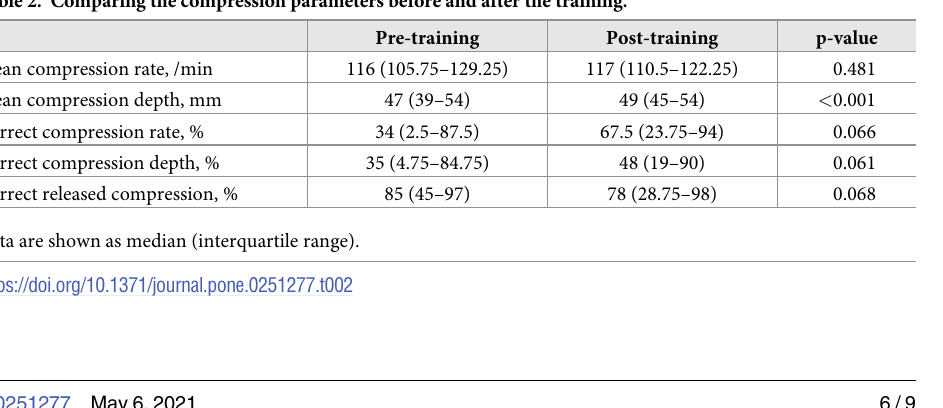
Table 2. Comparing the compression parameters before and after the training.